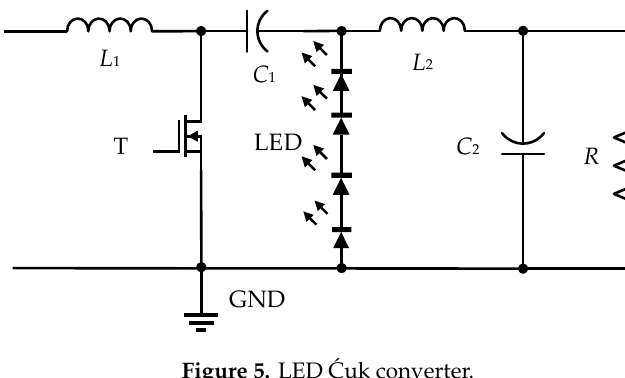
Figure 5. LED Ć uk converter.